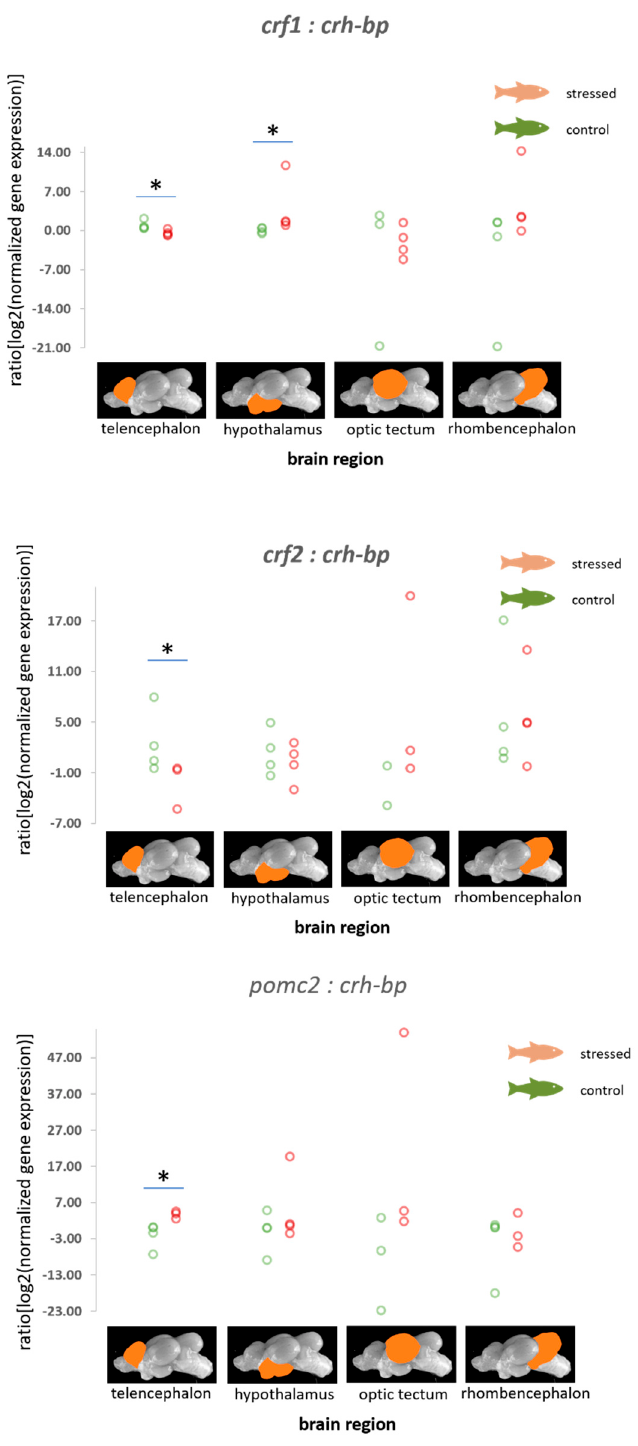
Figure 2. Ratios of the normalized fold expression of crf1, crf2 , and pomc2 relative to crh-bp in each of the 4 brain parts in the control fish and fish 30 min after the air exposure with 95% confidence intervals of 0.51 to 1.83 for the control and − 0.77 to 0.17 for the stressed fish for the ratio of crf1:crh-bp in the telencephalon, − 0.44 to 0.53 for the control and 1.16 to 9.20 for the stressed fish for the ratio of crf1:crh-bp in the hypothalamus; 0.00 to 6.48 for the control and − 8.07 to − 0.61 for the stressed fish for the ratio of crf2:crh-bp in the telencephalon, and − 7.16 to − 0.13 for the control and 2.62 to 4.42 for the stressed fish for the ratio of pomc2:crh-bp in the telencephalon derived from the adjusted bootstrap percentile (BCa) method; n = 4 per treatment, * = significance according to the Mann–Whitney U tests, p < 0.05.